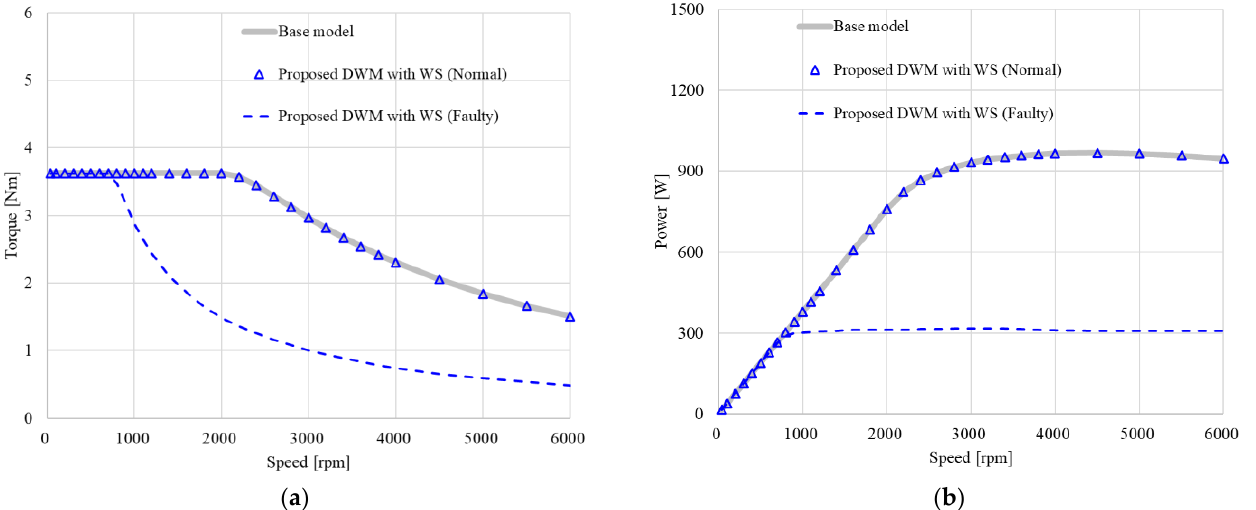
Figure 16. Comparison of torque and power characteristics between the base model and the pro- posed DWM with WS: ( a ) Torque; ( b ) Power.